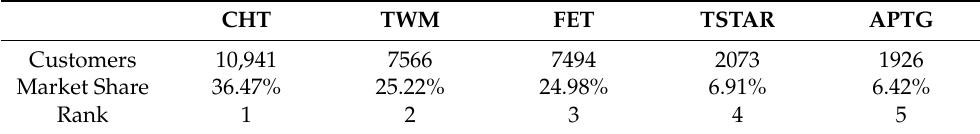
Table 4. Market share of the mobile operators in Taiwan.